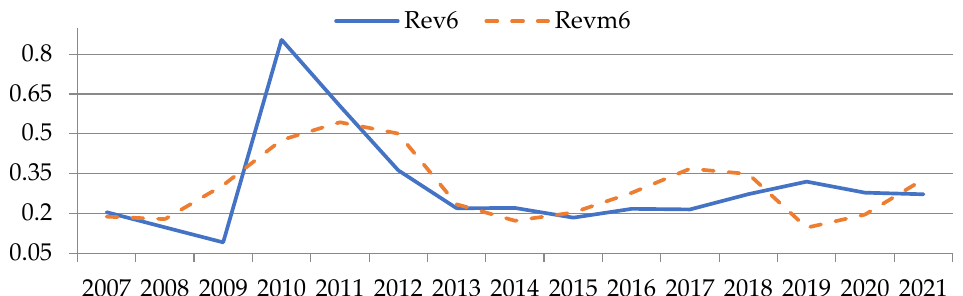
Figure 5. Comparison between real revenue and model value calculated by Formula (1) for industry No. 5, (author’s results).